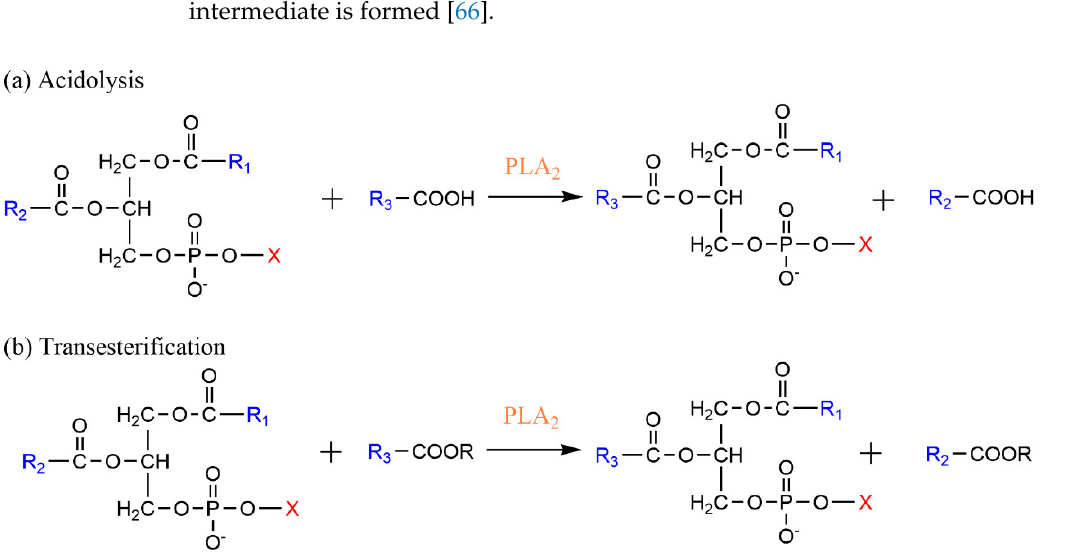
Figure 8. PLA 2 −catalyzed the exchange of fatty acid in the sn −2 position via acidolysis ( a ) or trans- Figure 8. PLA 2 − catalyzed the exchange of fatty acid in the sn − 2 position via acidolysis ( a ) or esterification ( b ) reaction. transesterification ( b )